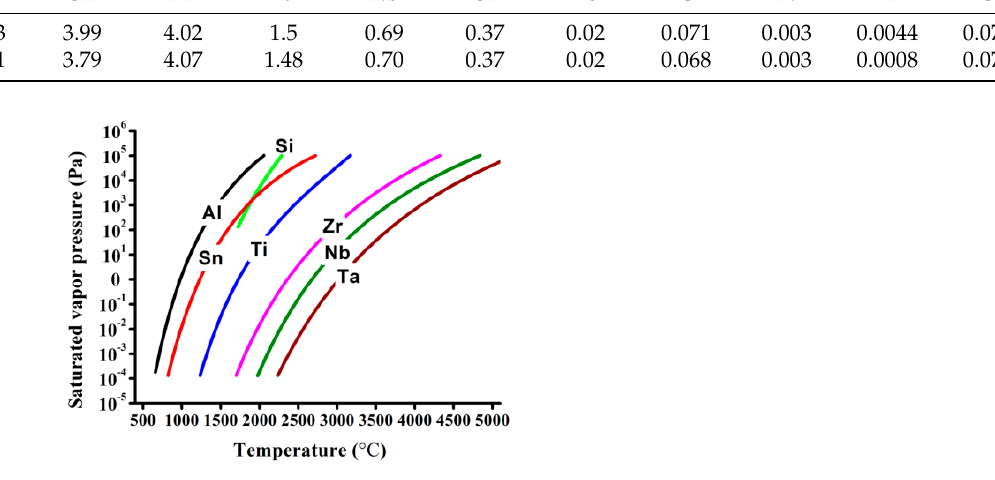
Figure 4. Saturated vapor pressure of pure elements in Ti60 alloy as a function of temperature